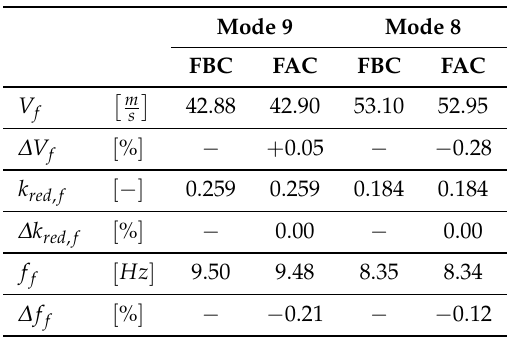
Figure 27. Comparison of SD-CFD and DLM modeling with regard to the resulting behaviour of the flutter modes. Table 4. Overview of the predicted flutter limits of the FBC and the FAC based on SD-CFD. Mode